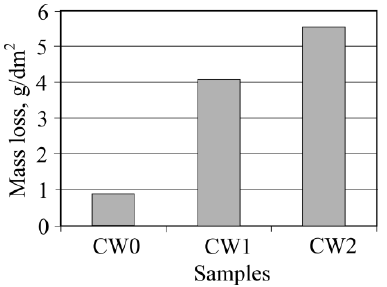
Figure 13. Dependence of samples’ mass losses after 56 test cycles on the amount of concrete waste.